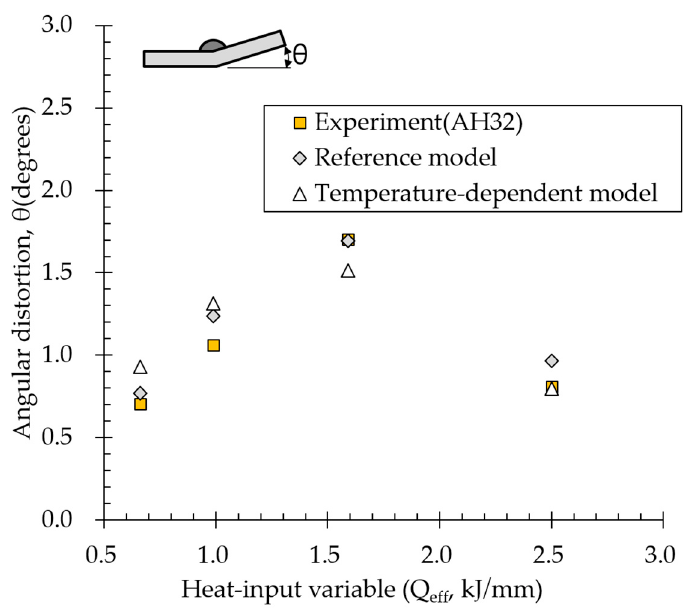
Figure 9. Angular distortion measured by experiment and two proposed models.